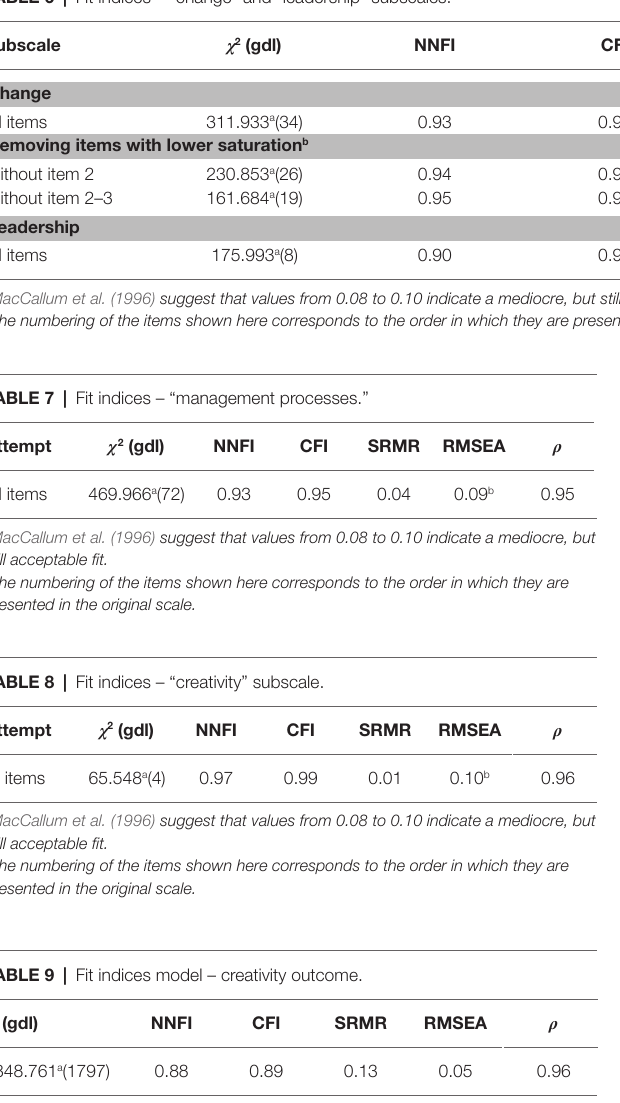
TABLE 6 | Fit indices – “change” and “leadership” subscales.